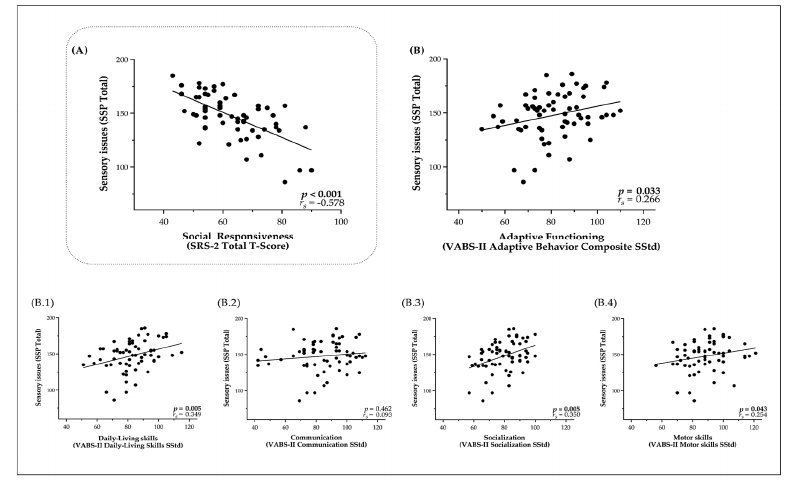
Figure 3. Correlations between Sensory issues (SSP Total score) is the ASD group and: A) Social difficulties (SRS-2 Total T-Score) ; B) Adaptive Functioning (VABS-II Adaptive Behavior Composite di ffi culties (SRS-2 Total T-Score); ( B ) Adaptive Functioning (VABS-II Adaptive Behavior Composite SStd) and subdomains ; B.1) Communication (VABS-II Communication SStd) ; B.2) Daily- living skills SStd) and subdomains; ( B.1 ) Communication (VABS-II Communication SStd); ( B.2 ) Daily- living skills (VABS-II Daily-living skills SStd); B.3) Socialization (VABS-II Socialization SStd); and B.4) Motor skills (VABS-II Motor skills SStd). (VABS-II Daily-living skills SStd); ( B.3 ) Socialization (VABS-II Socialization SStd); and ( B.4 ) Motor skills (VABS-II Motor skills